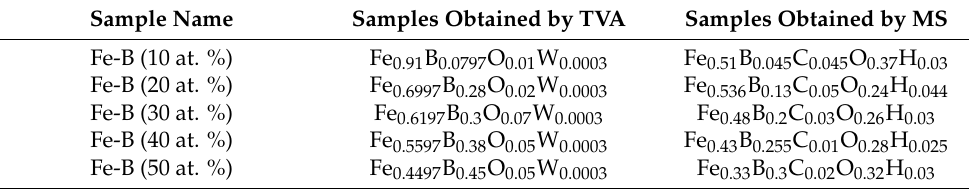
Table 2. Atomic composition of samples Fe-B obtained by TVA and MS, respectively.